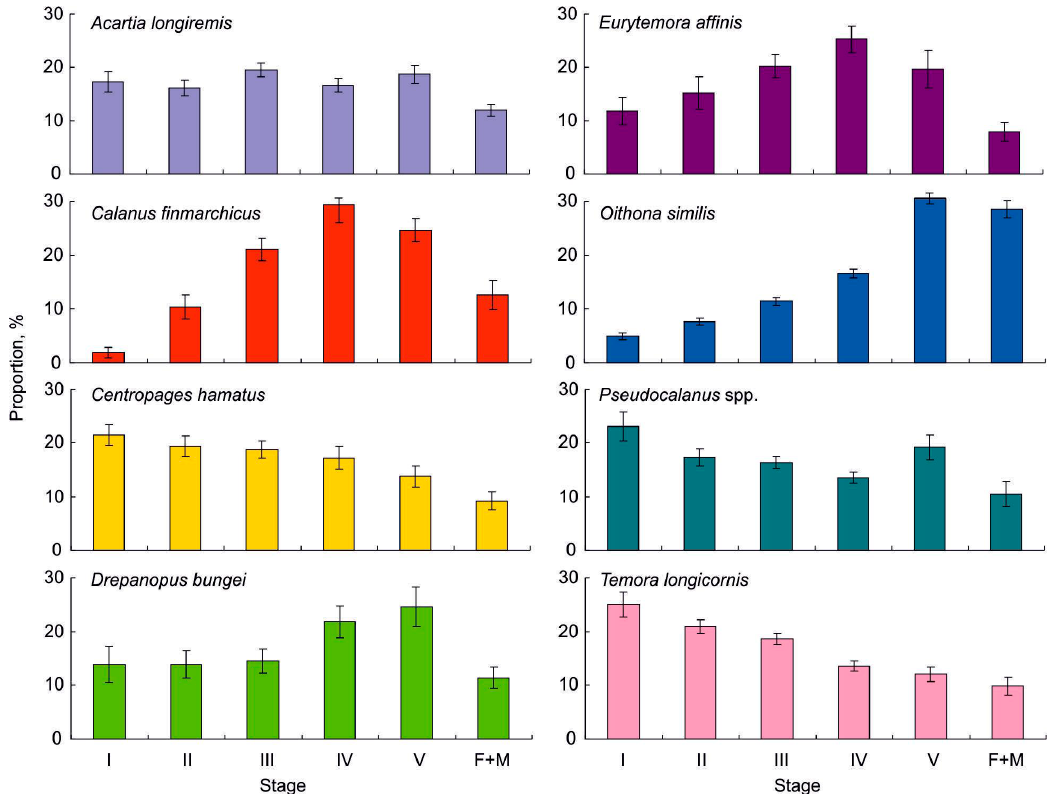
Figure 4. Population structure (mean relative abundance with standard error, %) of common copepod taxa in the south-eastern Barents Sea in summer 2012. I–V—copepodites I–V, F—females, M—males.